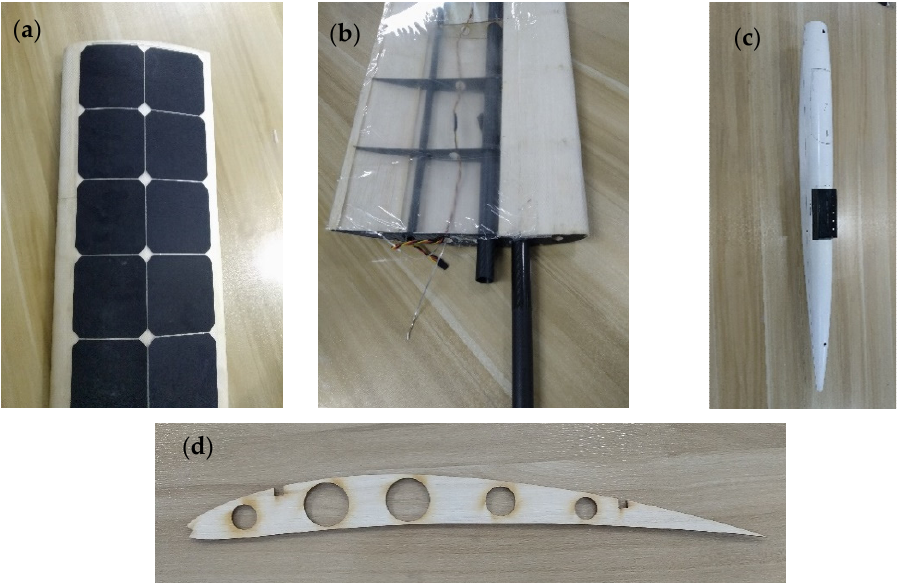
Figure 1. Structural components of solar UAV: ( a ) Upper wing, ( b ) Lower wing, ( c ) Fuselage, ( d ) Wing rib.